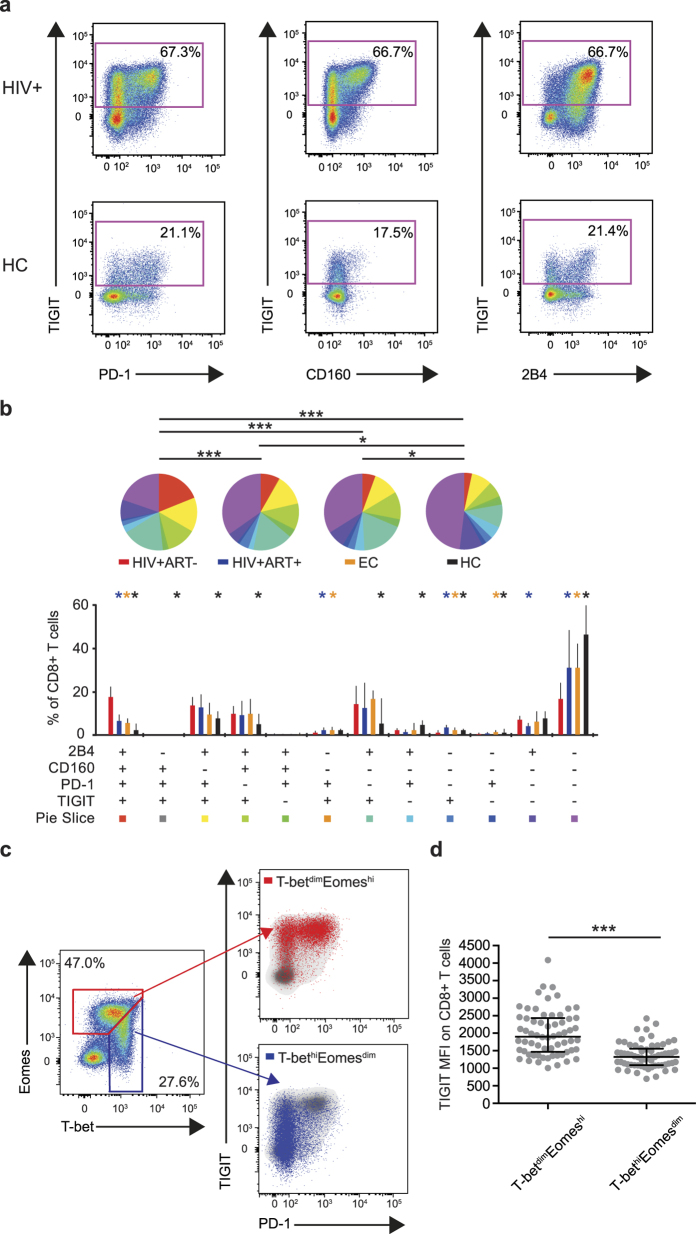
Expression of TIGIT, PD-1, CD160, 2B4 and T-box transcription factors on CD8+ T cells in HIV-positive subjects (a) Gating procedure for co-expression of TIGIT versus PD-1, CD160 and 2B4 on CD8+ T cells in a representative HIV+ subject (HIV+) and a healthy control (HC) subject. (b) SPICE analysis of combinations of TIGIT, PD-1, CD160 and 2B4 on total CD8+ T cells in HIV-positive treatment naïve (HIV+ART−, red, n = 30), long-term treated (HIV+ART−, blue, n = 20), elite controller (EC, orange, n = 14) subjects and healthy controls (HC, black, n = 26). (c) Expression of T-betdimEomeshi (red) and T-bethiEomesdim (blue) shown for total CD8+ T cells. Gating of T-bet and Eomes populations was performed according to previously used gating strategies9. (d) TIGIT expression on T-betdimEomeshi and T-bethiEomesdim populations on total CD8+ T cells in HIV+ART−, HIV+ART+ and EC subjects (n = 64). Permutation test was performed between the pie charts. Bar charts show median and IQR. The Wilcoxon matched-pairs signed rank test was used to compare paired samples. ***P < 0.001.